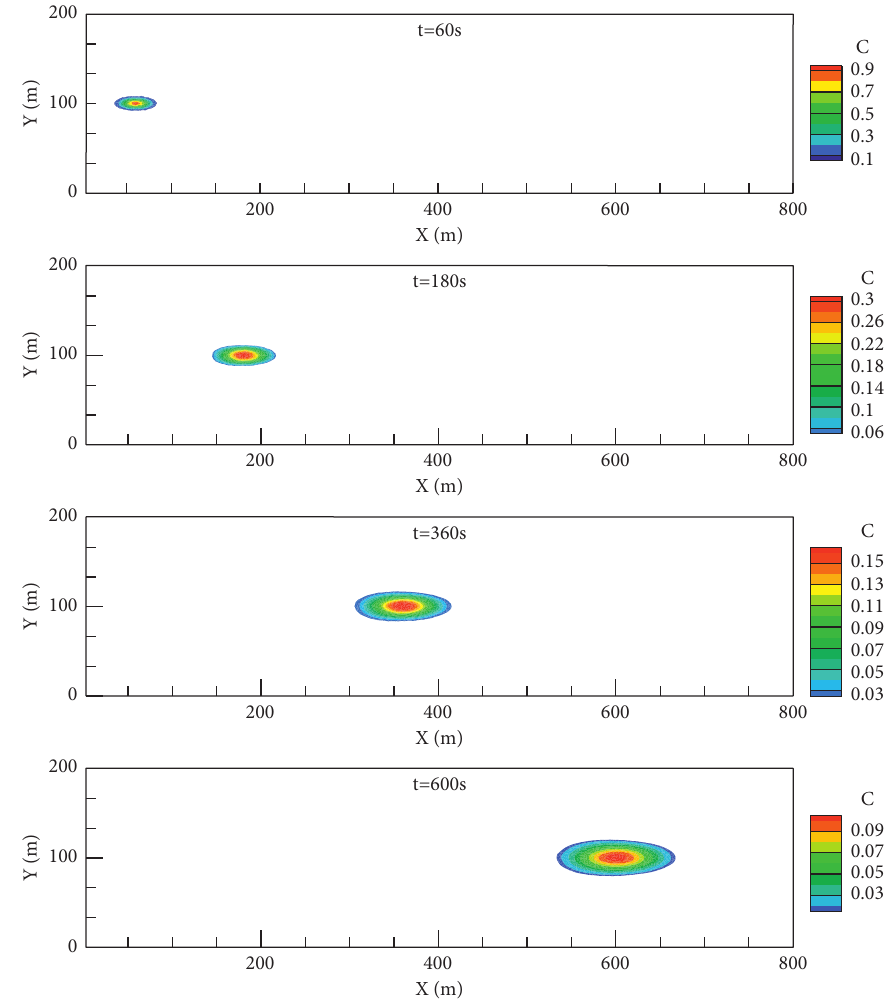
Figure 3: Advection and diffusion of a solute cloud: concentration field at different